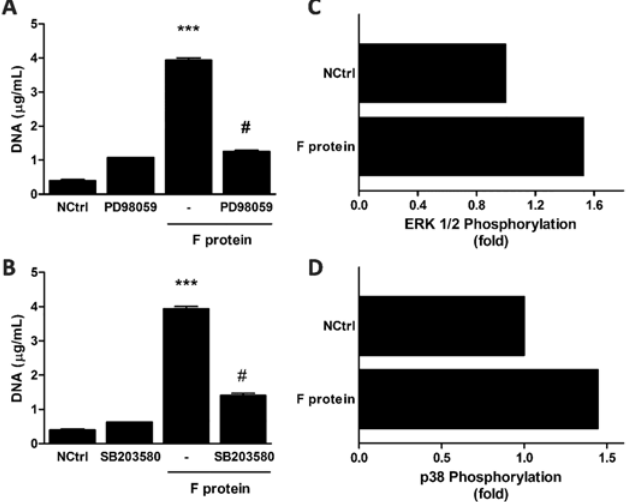
Fig 5. F protein activates ERK and p38 MAPK to induce NET formation. (A,B) Neutrophils (2 x 10 6 /mL) were pretreated with PD98059 (30 μ M) or SB203580 (10 μ M) for 1 h and stimulated with F protein (1 μ g/mL) for 3 h at 37°C with 5% CO 2 . NETs were quantified in culture supernatants using Quant-iT dsDNA HS kit. Data are representative of 3 separate experiments performed in triplicates and represent mean ± SEM. *** p < 0.001 when compared to negative control (NCtrl); #p < 0.001 when compared to F protein-treated cells. (C,D) Neutrophils (1 x 10 6 /mL) were stimulated with F protein (1 μ g/mL) for 5 min at 37°C with 5% CO 2 and stained for phosphorylated proteins (ERK 1/2 and p38 MAPK), according to Materials and Methods. Proteins phosphorylation was analyzed by flow cytometry using FACSCanto II flow cytometer. Neutrophils gate was based on FSC x SSC distribution. Phosphorylation of protein pathways are presented as fold increase relative to unstimulated neutrophils (NCtrl). Data are representative of 2 separate experiments with similar